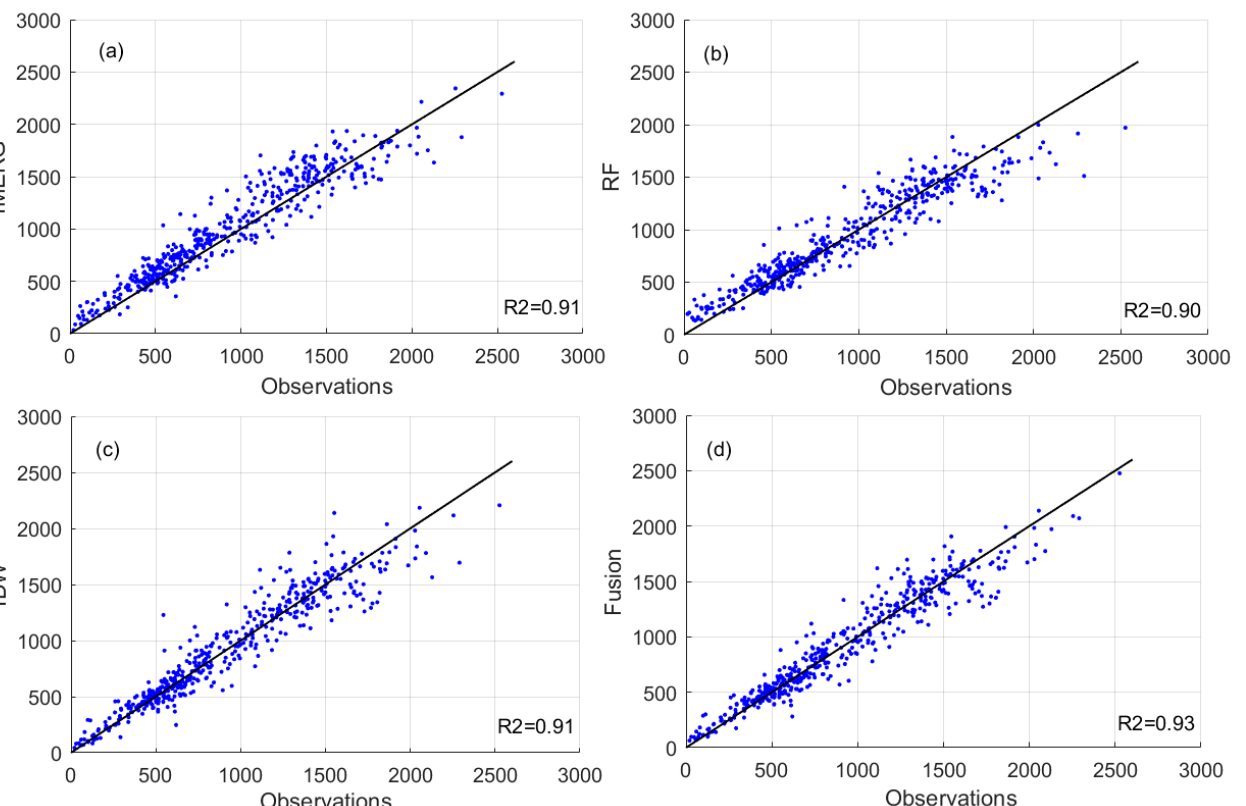
Figure 4. Scatter plot of estimated precipitation and observations in the year 2018. ( a ) IMERG; ( b ) RF; ( c ) IDW; ( d ) The merging method.